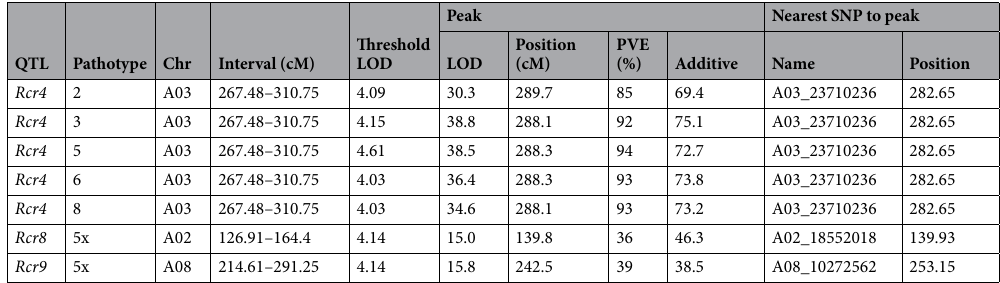
Table 3. QTL position and phenotypic variation explained (PVE) for resistance to six pathotypes of Plasmodiophora brassicae in Brassica rapa line